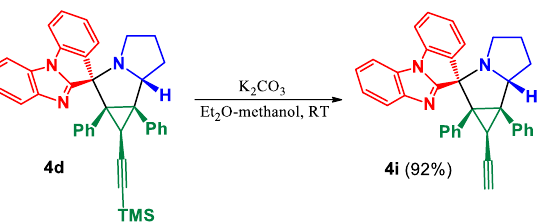
to obtain cyclopropylacetylene 4i in a 92% yield (Scheme 2).